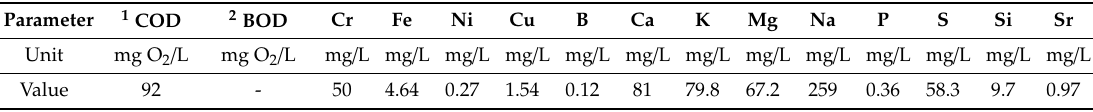
Table 2. Chemical composition of the TAMEG-Rouiba Tannery e ffl uent after pre-filtration using a membrane filter with an average pore size of 0.45 µ m.